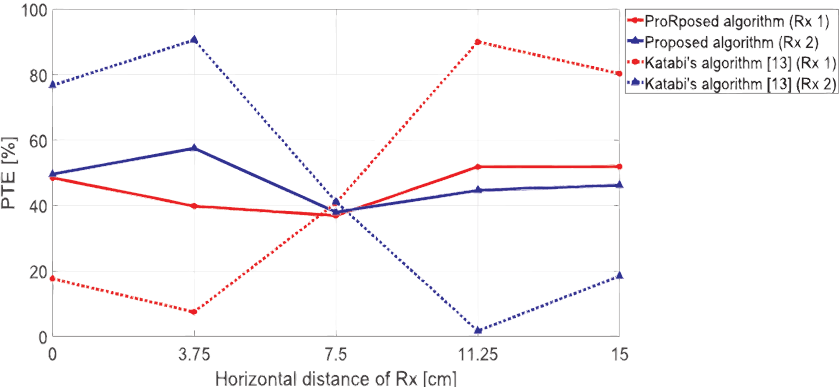
Figure 5. PTE results for each Rx coil. Proposed algorithm vs. Katabi’s algorithm.